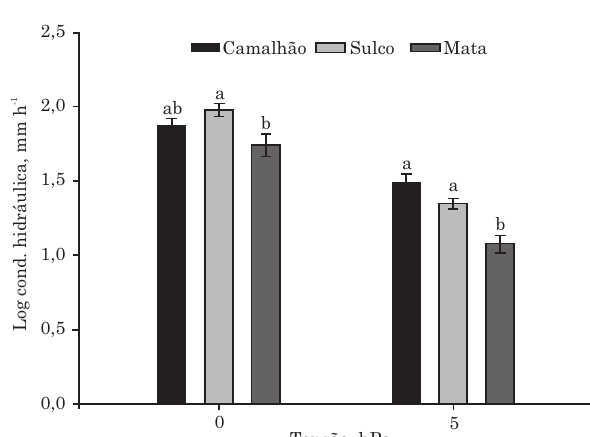
Figura 4. Condutividade hidráulica da superfície do solo, com desvios-padrão da média, para os sistemas de manejo em sulco e camalhão e sob mata nativa secundária. Médias seguidas pela mesma letra minúscula na mesma tensão não diferem pelo teste de Tukey a 5